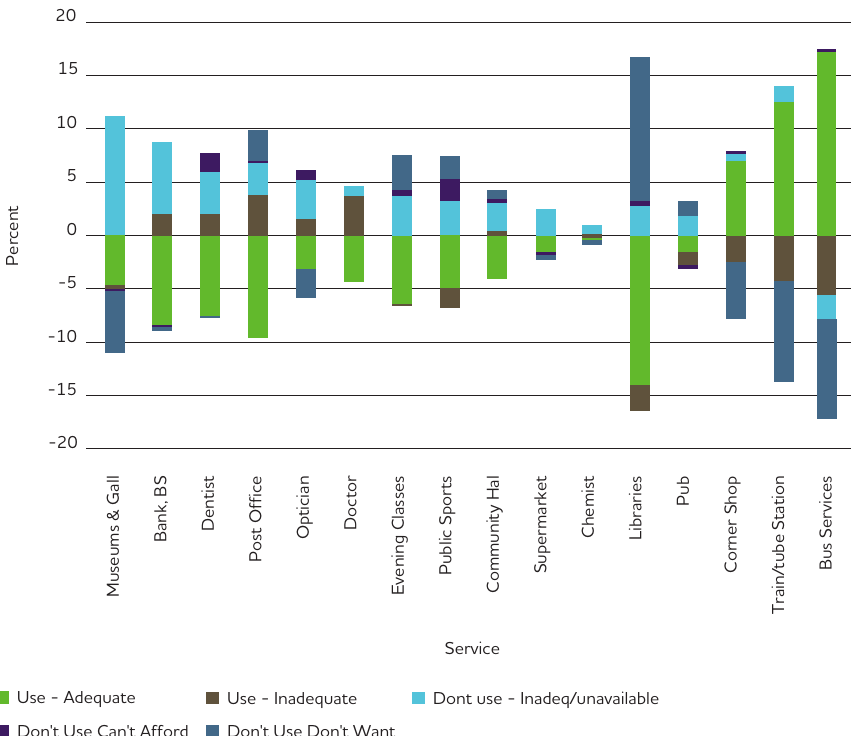
Figure 14: Change in Usage and Constraints for Universal Public &